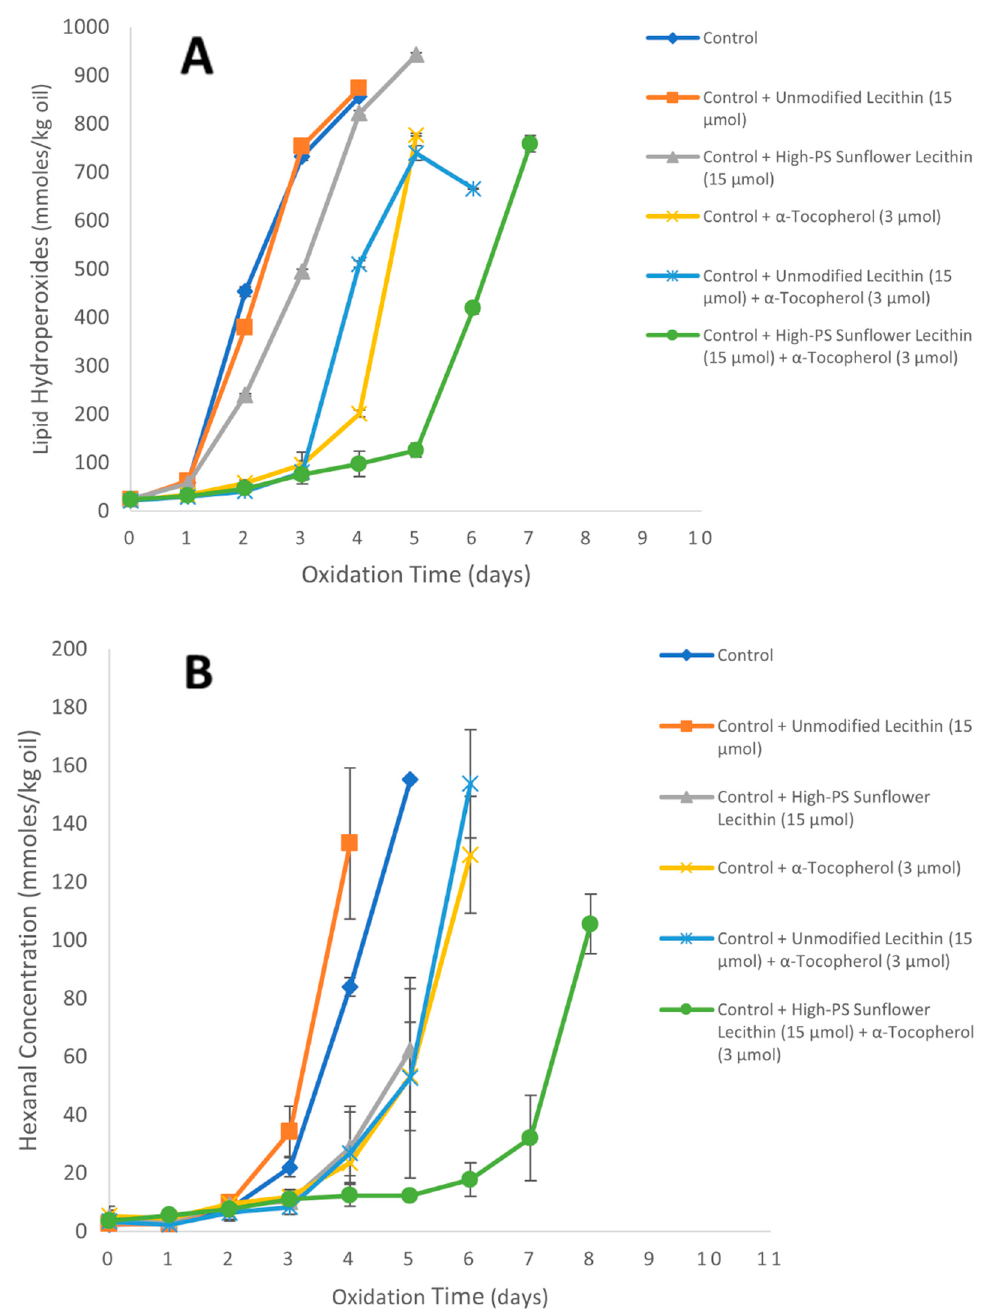
Figure 6. Formation of lipid hydroperoxides ( A ) and hexanal ( B ) in 1% stripped soybean oil-in- water emulsions stabilized with Tween 20 containing 3.0 µmol α -tocopherol/kg of emulsion and/or 15.0 µmol of unmodified or high-PS modified sunflower lecithin/kg emulsion at 20 °C. Each value represents the mean ( n = 3) ± standard deviations. Some error bars lie within the data points. The addition of 15.0 µ mol unmodified egg lecithin/kg of emulsion gave